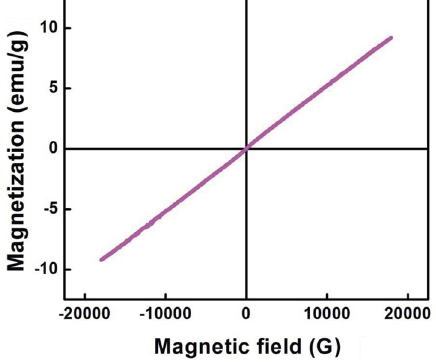
Fig. 10 Room temperature M − H